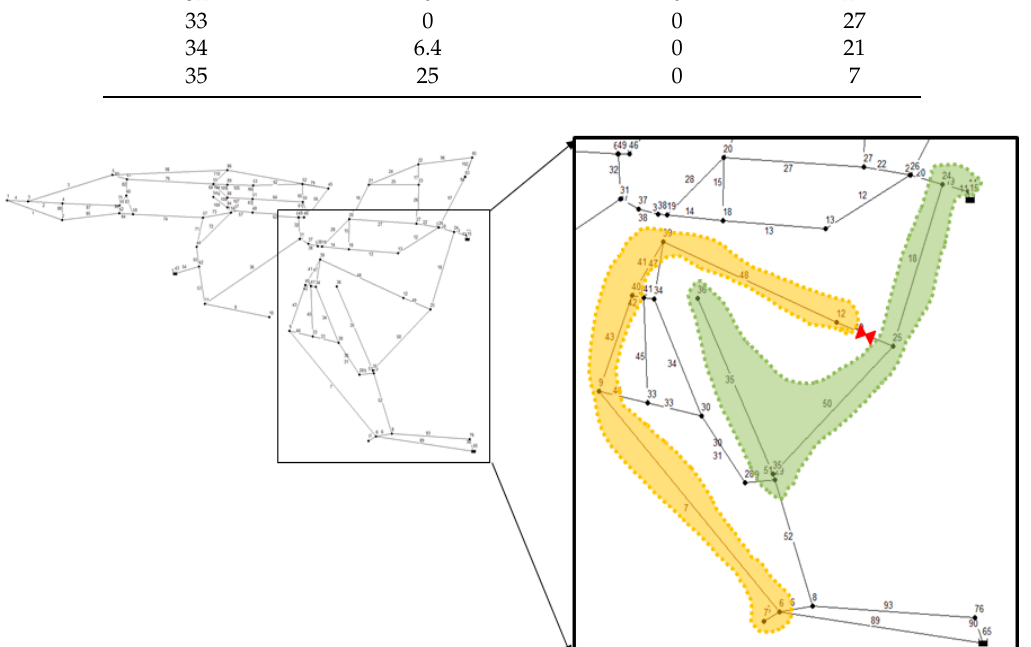
Figure 8. Five segments above the dividing priority.